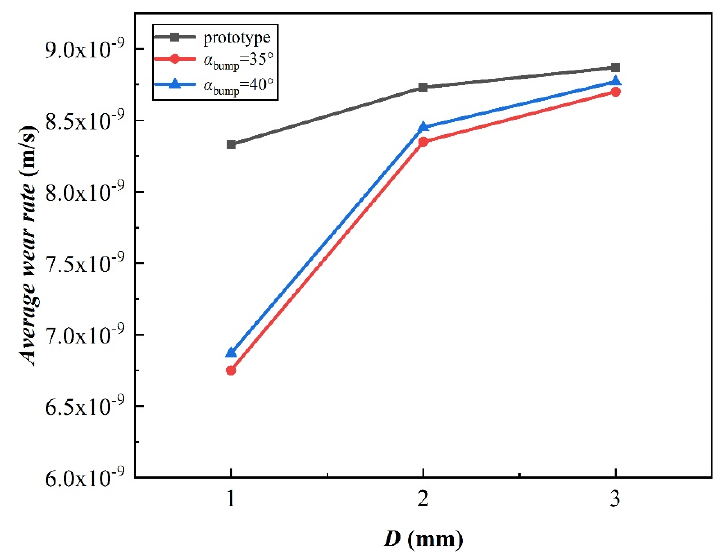
Figure 17. The average wear rate of the outer wall surface of the three bend pipes for different particle sizes.